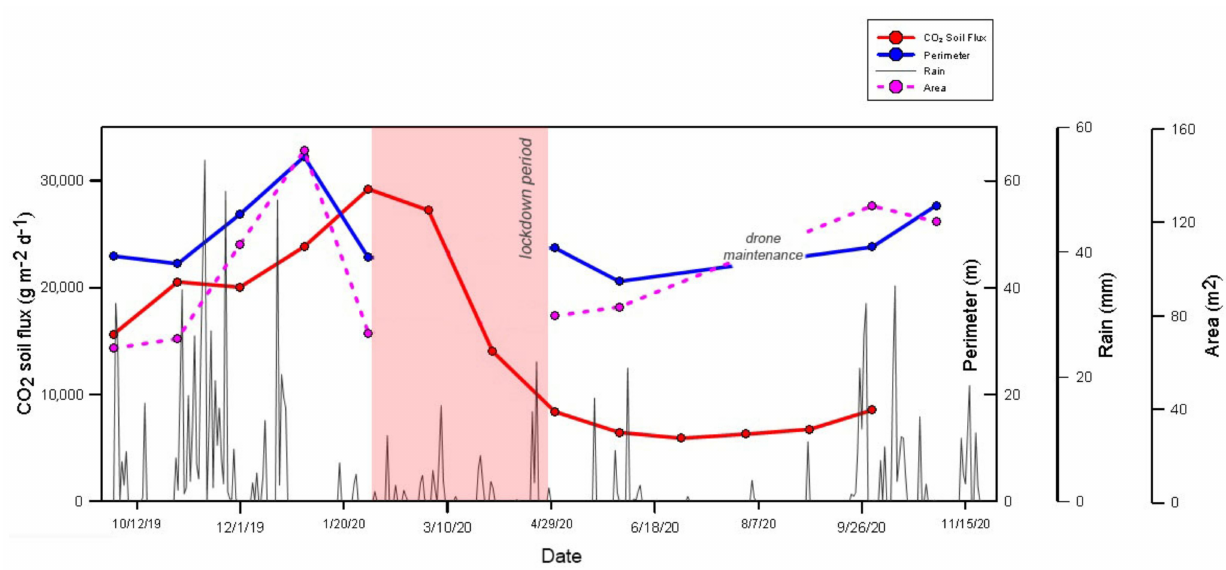
Figure 15. Comparison between the perimeter and area of the bubbling mud pool time series, the rainfall rate, and the CO 2 soil flux.